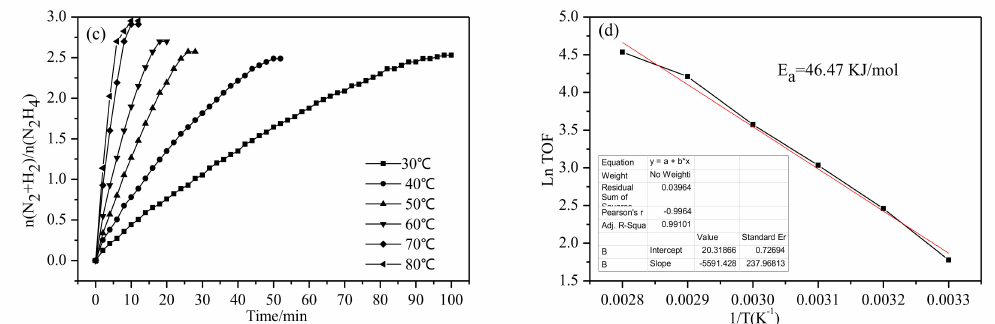
Figure 6. Influence of reaction temperature on the N 2 H 4 · H 2 O decomposition at the examined temperature range from 30 ◦ C to 80 ◦ C and Arrhenius treatment of the temperature-dependent rate data for determination of activation energy of the catalysts ( a , b ) Ni 9 Mo 1 (Pr 2 O 3 ) 0.375 and ( c , d ) Ni 4 Mo@Cu 2 O.